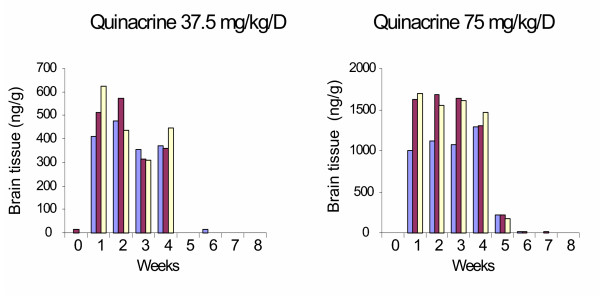
Quinacrine brain levels in mice (FVB strain) administered oral quinacrine at 37.5 or 75 mg/kg/D for 4 weeks